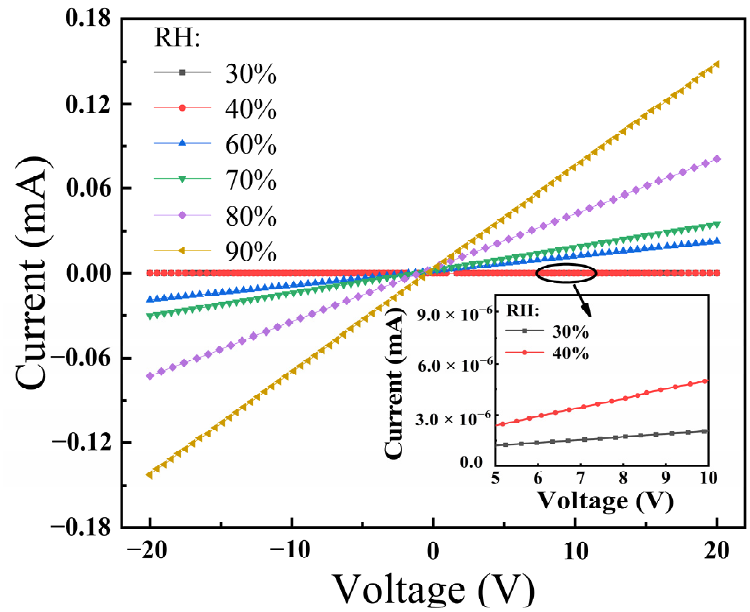
Figure 8. Dependence of current on voltage for the BiFeO 3 film at various RHs. Inset: the enlarged I – V vs. %RH plot (30 – 40% RH range).